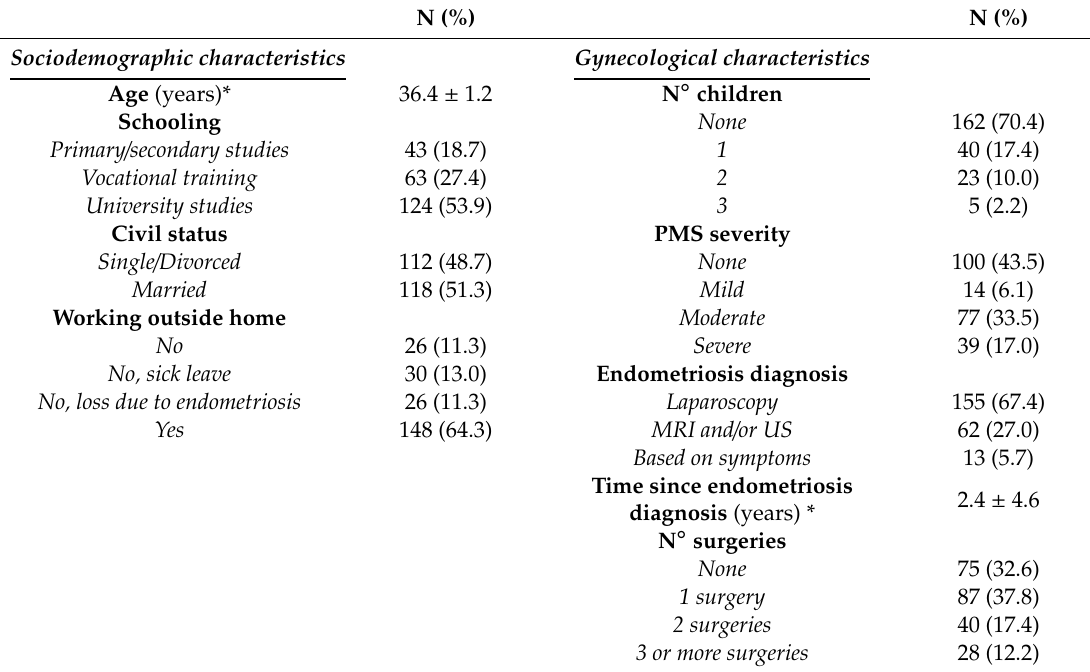
Table 1. Baseline characteristics of the study population (N = 230).